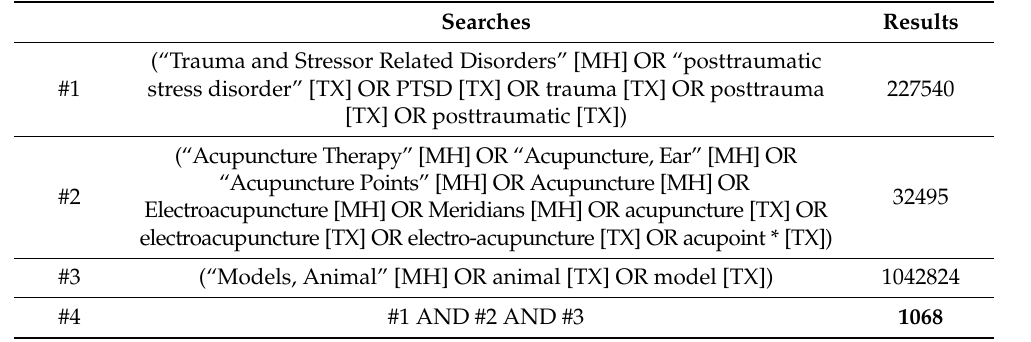
Table A5. CINAHL via EBSCO.